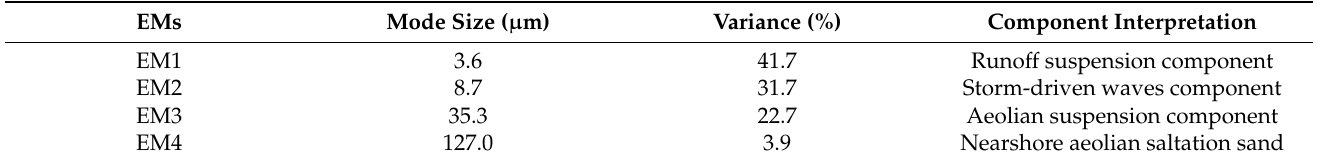
Table 2. Characteristics of the four EMs extracted from core AGL-2010. For the curves of each EM, see Figure